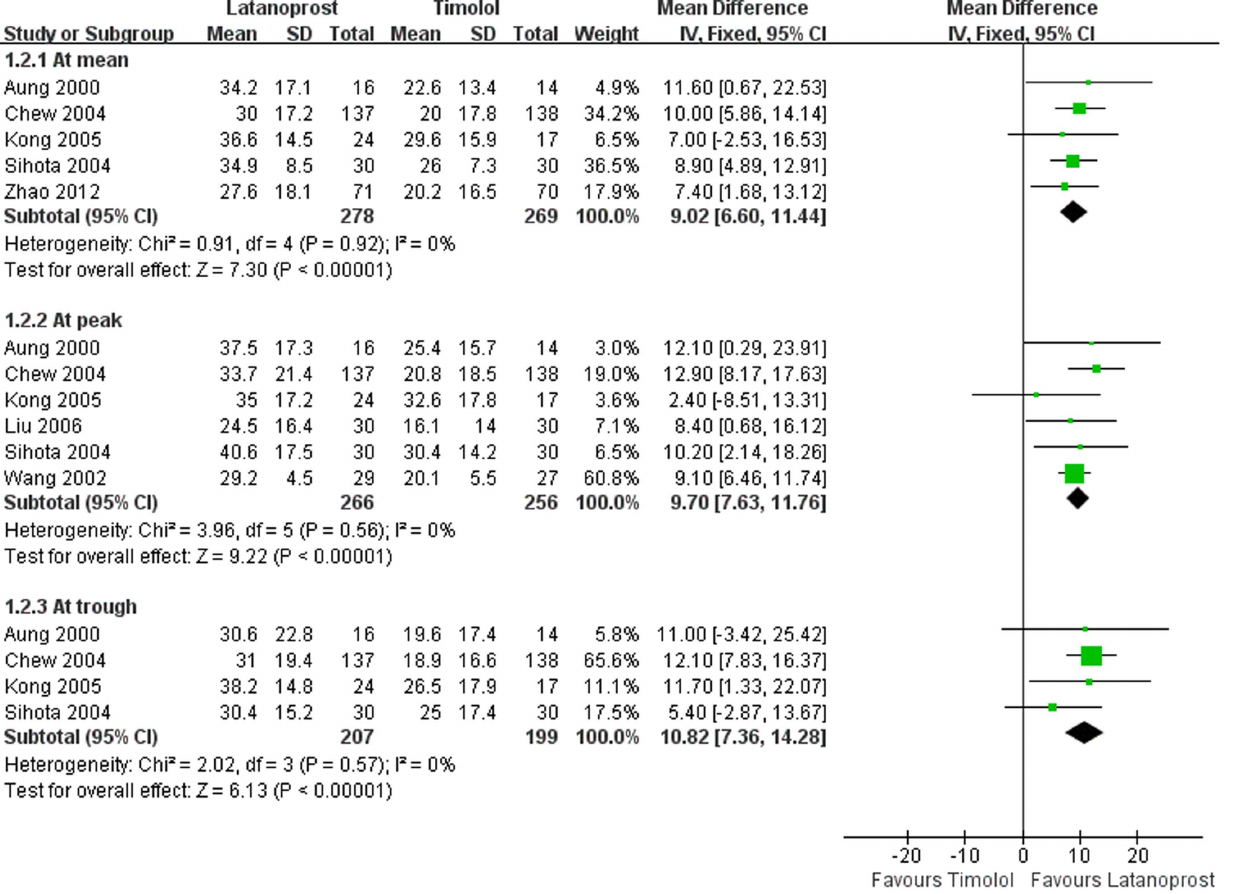
Figure 5. Comparison of Relative IOP reductions between latanoprost and timolol.